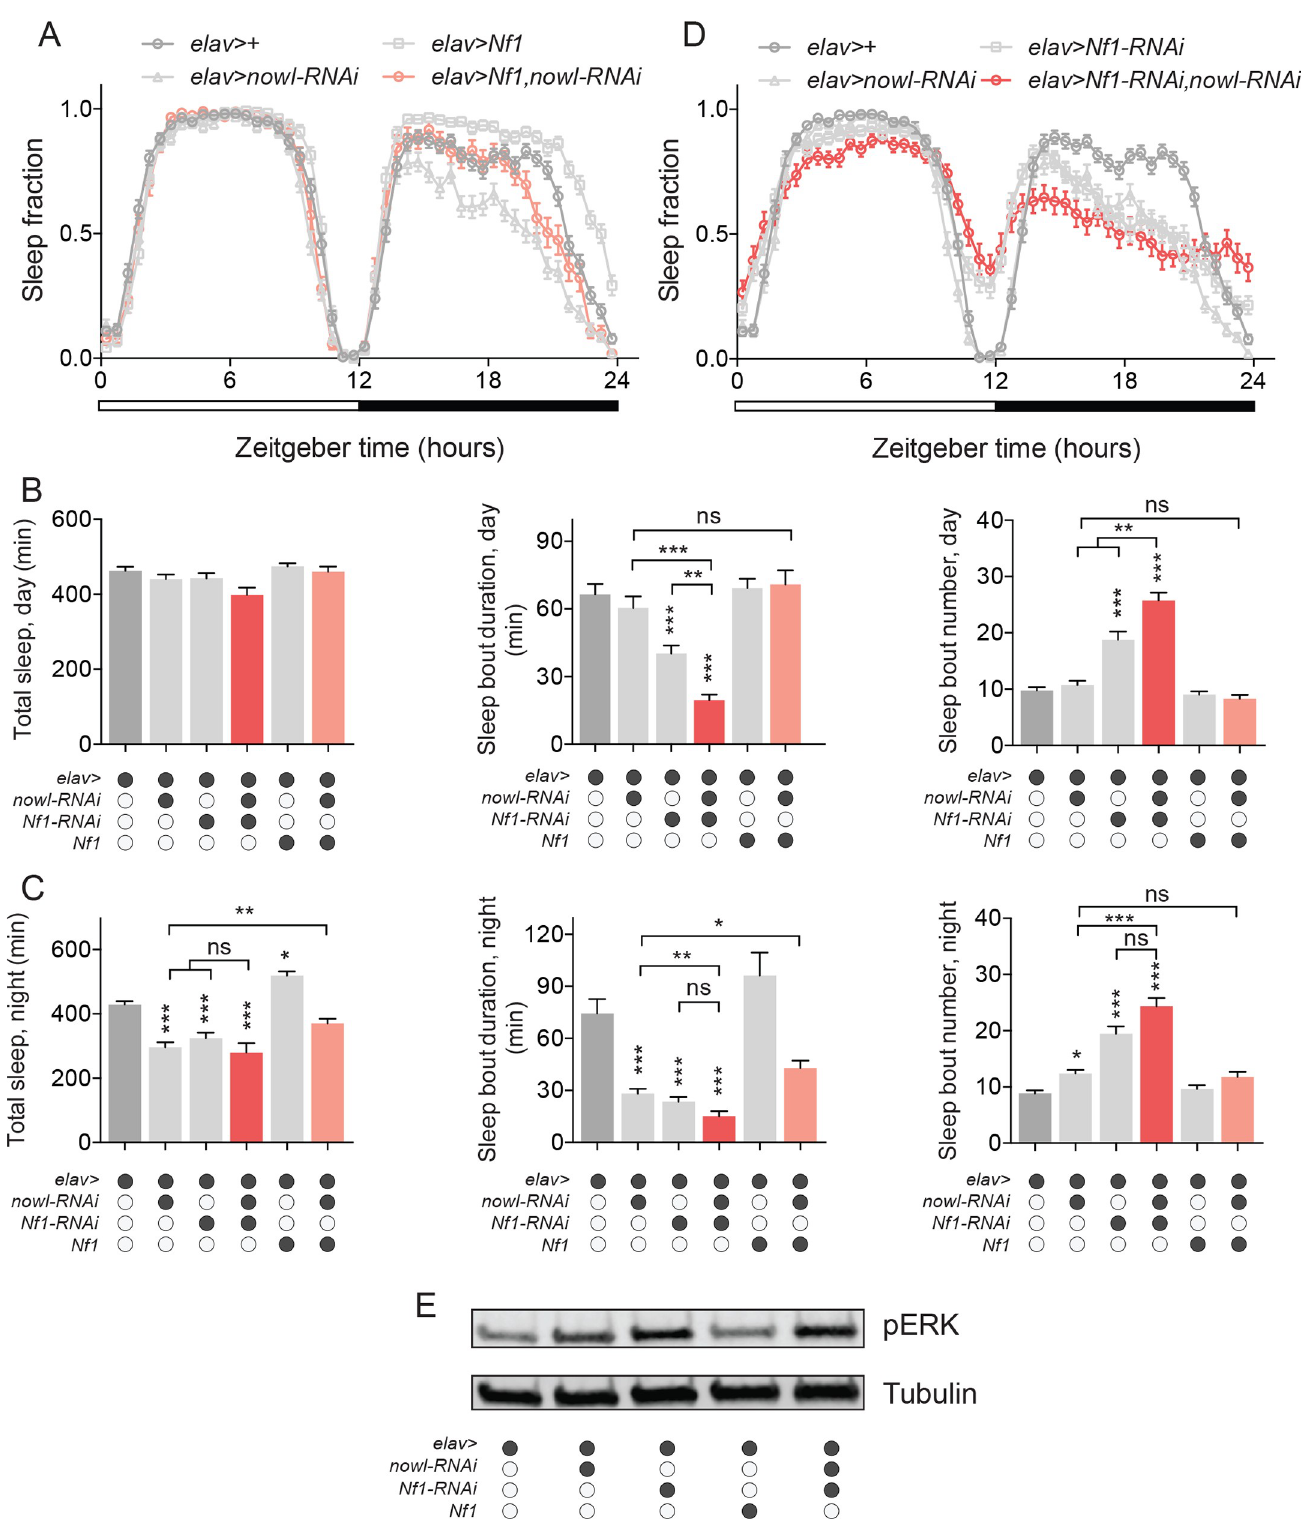
Fig 5. nowl and Nf1 interact in the regulation of sleep. (A) Daily sleep profiles of males under a 12-hour light/dark (white and black bars) cycle in 30-minute intervals. In elav > Nf1 , nowl-RNAi animals (with neuronal overexpression of Nf1 and simultaneous knockdown of nowl ), night-time sleep is partially restored compared to nowl knockdown alone. (B and C) Quantification of daytime (B) and nighttime (C) total sleep, sleep-bout duration, and sleep-bout numbers in males.